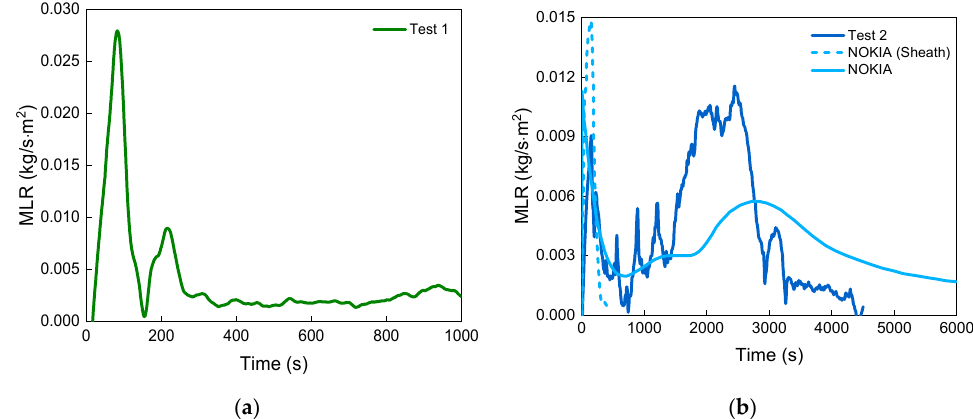
Figure 9. Mass loss rates for Cable ZRC-YJV-8.7/10 3 × 95 mm 2 in: ( a ) Test 1; ( b ) Test 2 in comparison with other cable tests.